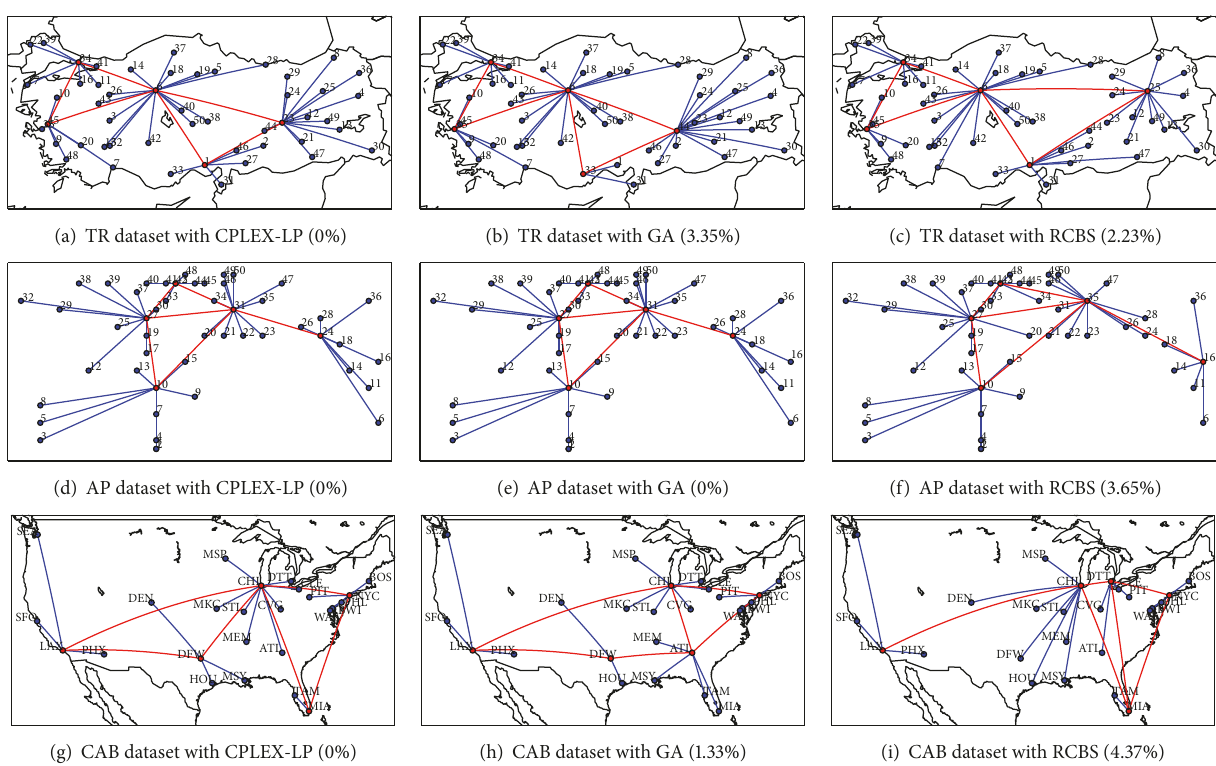
Figure 10: Visualization of ISA problems for the TR dataset with 𝑛 = 50 , 𝑝 = 5 , 𝑞 = 6 , and 𝛼 = 0.5 , AP dataset with 𝑛 = 50 , 𝑝 = 5 , 𝑞 = 6 , and 𝛼 = 0.75 , and CAB dataset with 𝑛 = 25 , 𝑝 = 5 , 𝑞 = 6 , and 𝛼 = 0.5 : red points and blue points are hubs and nonhub nodes. The red links are the links between hubs. For the TR dataset, the structures of links obtained by three methods are similar to each other. For the AP dataset, the optimal solution is obtained with CPLEX-LP and GA while RCBS selects node 35 and node 16 as hubs because of their high importance. For the CAB dataset, CPLEX-LP provides an optimal solution. The solutions of GA and CPLEX-LP only have a difference of 1.33% while having significantly different hub assignments in the figures. RCBS still selects Detroit (DTT) as a hub instead of Dallas